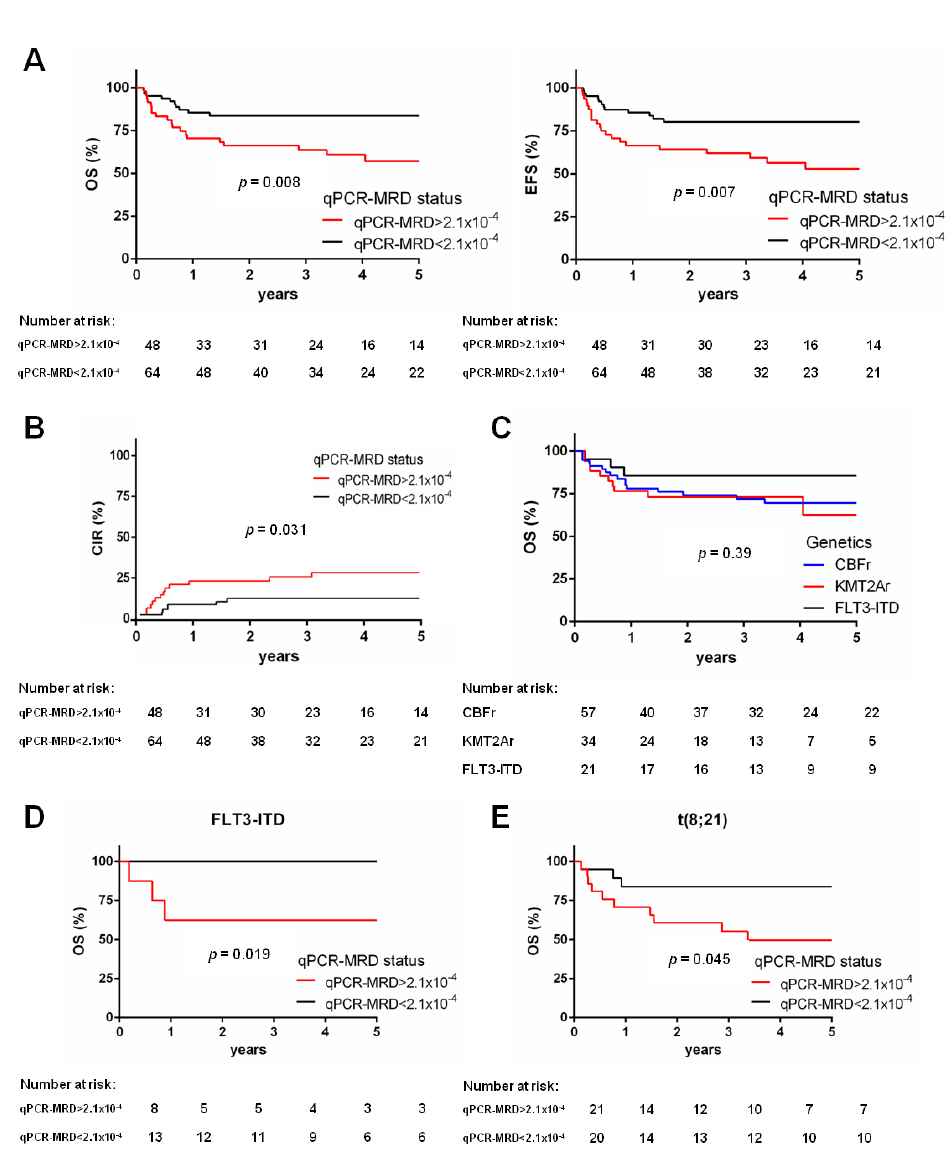
Figure 2. qPCR-MRD values above 2.1 × 10 − 4 impact on transplantation outcome: ( A ) Kaplan–Meier curves showing that patients who underwent HSCT with qPCR-MRD values above 2.1 × 10 − 4 ( n = 48) have a worse OS with respect to patients receiving transplant with qPCR-MRD values below 2.1 × 10 − 4 ( n = 64) (57.1% vs. 83.7%, p = 0.008), EFS for the same groups of patients (52.9% vs. 80.2%, p = 0.007); ( B ) cumulative incidence of relapse for cases with qPCR-MRD values above 2.1 × 10 − 4 ( n = 48) and patients with qPCR-MRD values below 2.1 × 10 − 4 ( n = 64) (26% vs. 10%, p = 0.031); ( C ) five-year OS for patients according to their genetics: CBF r ( n = 57), KMT2A r ( n = 34), and FLT3 -ITD ( n = 21) (survival 69.6% vs. 62.7% vs. 85.5%, respectively, p = 0.39); ( D ) Kaplan_Meier survival curves of OS for children with FLT3 -ITD mutation given transplantation with qPCR-MRD values above 2.1 × 10 −4 ( n = 8) or with qPCR-MRD values below 2.1 × 10 −4 ( n = 13) (62.5% vs. 100%, p = 0.019); ( E ) five-year probability of OS for children with t(8;21) RUNX1::RUNX1T1 rearrangement given HSCT with qPCR-MRD values above 2.1 × 10 −4 ( n = 21) or with qPCR-MRD values below 2.1 × 10 −4 ( n = 20) (49.7% vs. 83.8%, p = 0.045).